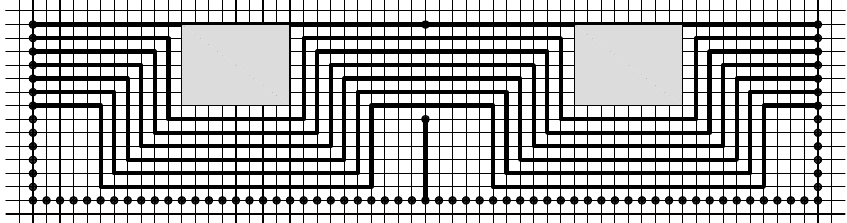
Figure 6. The labels of the top horizontal edges and the U -shape bends of the edges below that stretch.